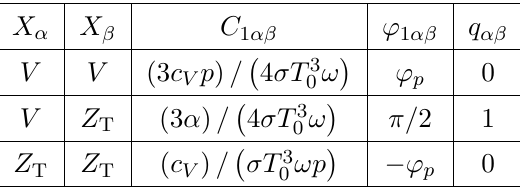
Table 2 . Summary of vector correlations. ’ p is de(cid:12)ned in eq.